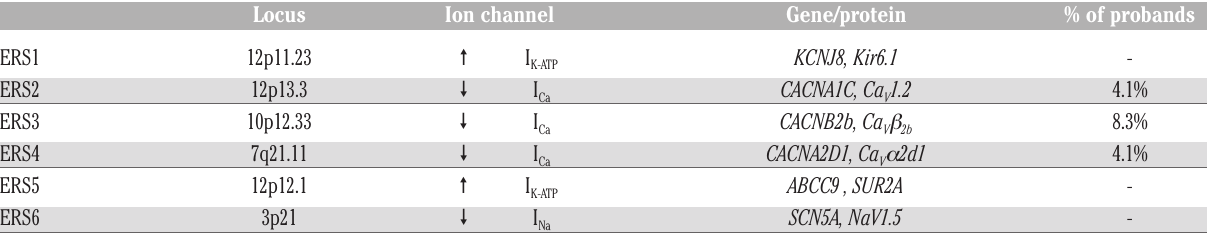
Table 3. Genetic basis of early repolarization